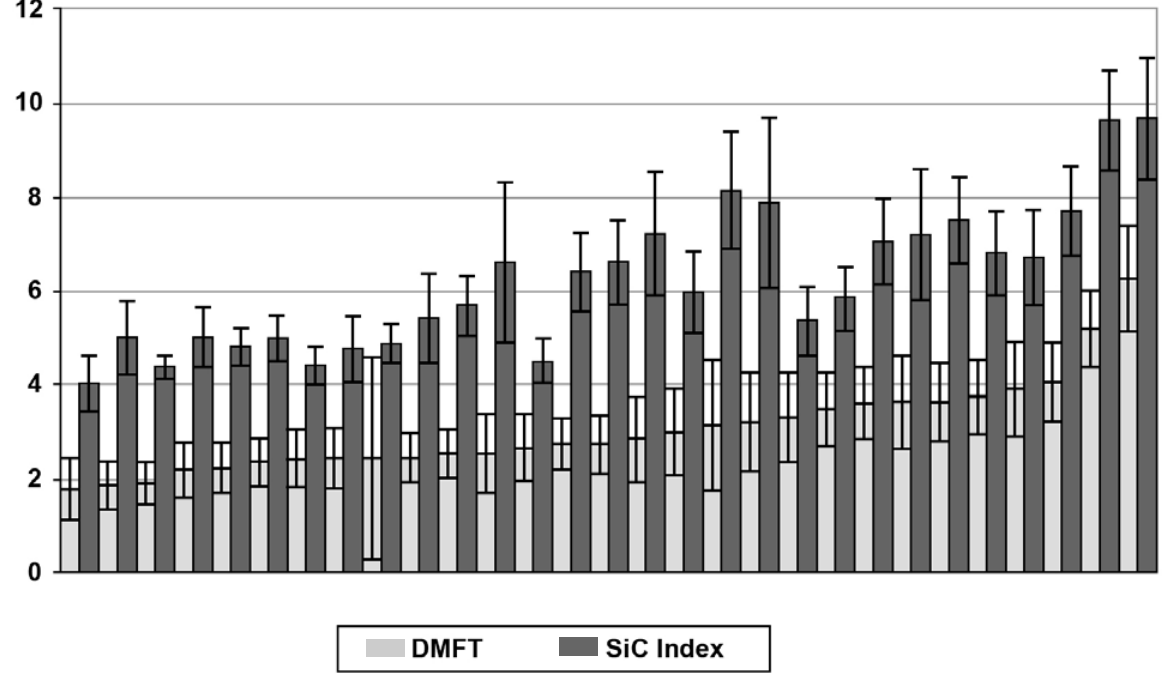
FIGURE 4- DMFT and SiC index with 95% confidence interval in cities from the region of Campinas, São Paulo State, Brazil (1998 to